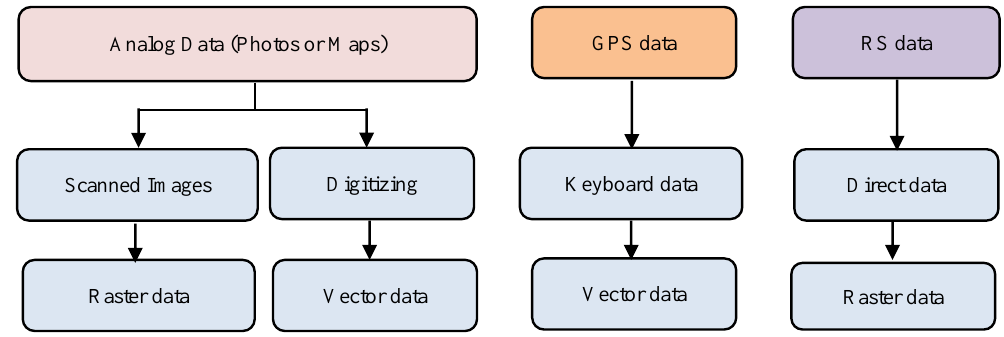
Figure 3. Data entry into GIS from different sources